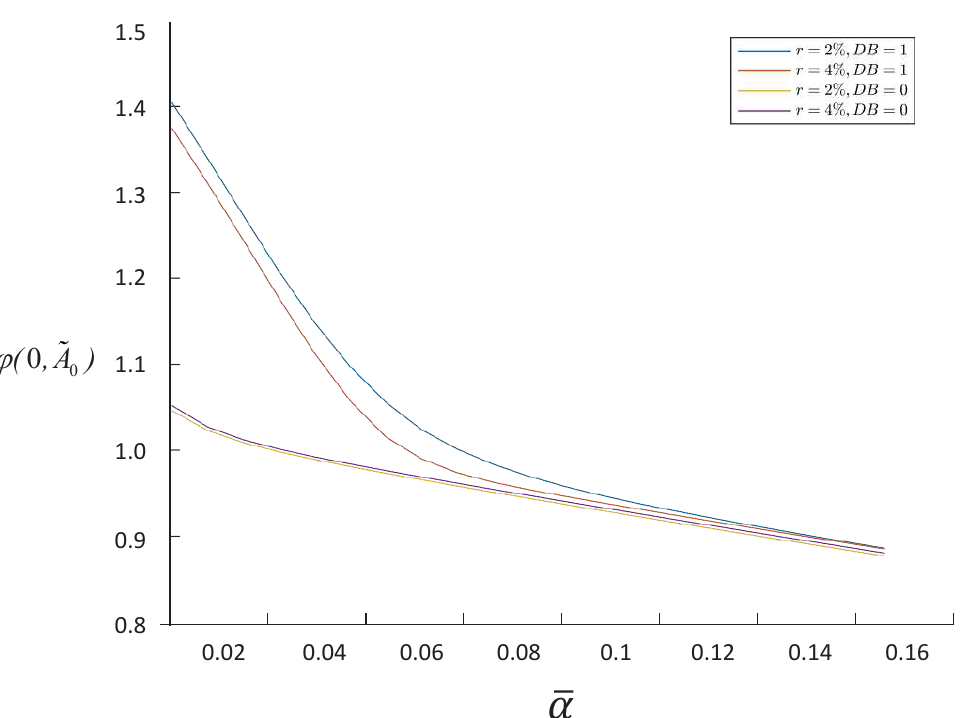
Figure A6. The contract value at inception as a function of the total fees α for Product A with and without DB for 2%, 4% r